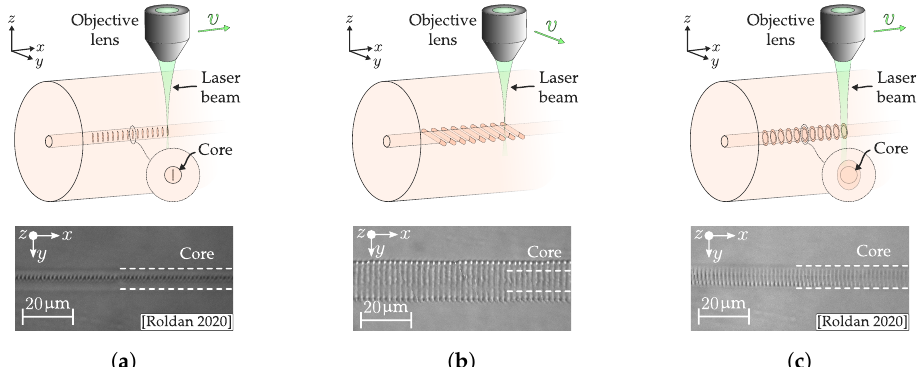
Figure 4. ( a ) Point-by-point inscription scheme and microscope image of the resulting FBG extracted from [83] ©IEEE. ( b ) Line-by-line inscription scheme and microscope capture of a typical FBG manufactured with this technique. ( c ) Plane-by-plane (Pl-b-Pl) inscription scheme and Pl-b-Pl grating inscribed with same writing setup as in ( a ) but with an slit of 1 mm width above microscope lens (extracted from [83] ©IEEE). All the samples were manufactured at the Photonics Engineering Group, Santander,